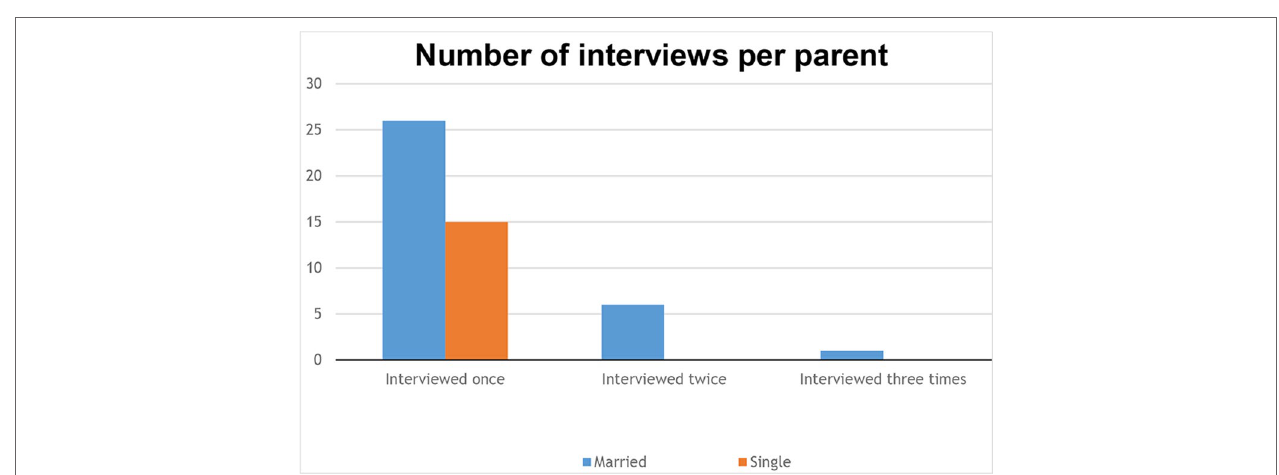
FIgURE 2 | Number of interviews per parent.